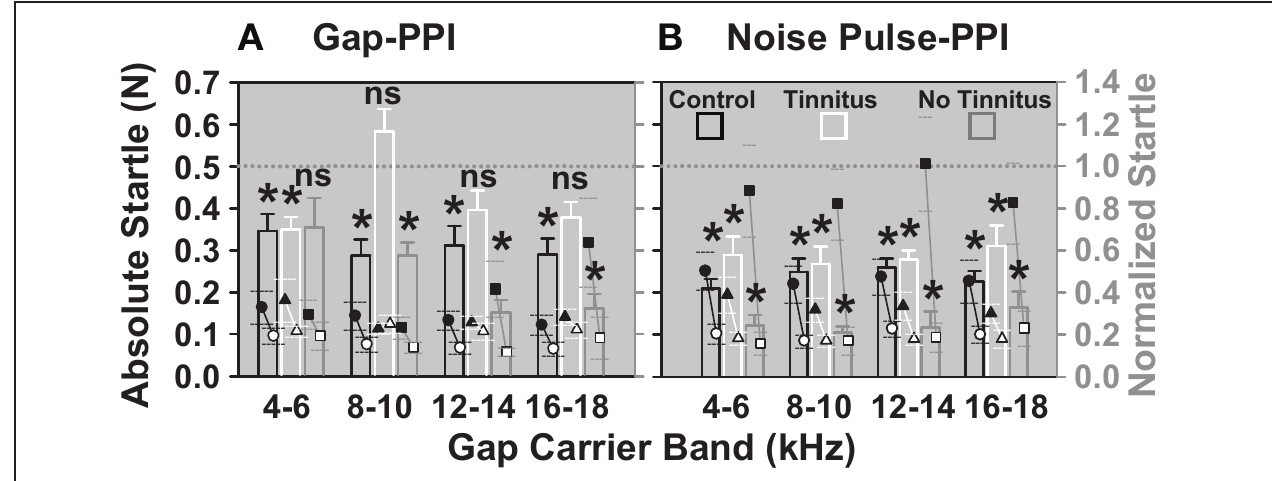
FIGURE 9 | Animals in the tinnitus group show no significant detection of gaps in gap-carrier bands between 8 and 18kHz. Normalized (bars, right Y axis, mean) and absolute startles (dot plots, left Y axis, mean ± 95% confidence interval) are shown for the two noise exposure groups and the control group after the noise/sham exposure. (A) Gap-PPI and (B) noise pulse-PPI. Black bars and circles: sham exposure control group ( n = 4), white bars and triangles: “tinnitus” group ( n = 4),